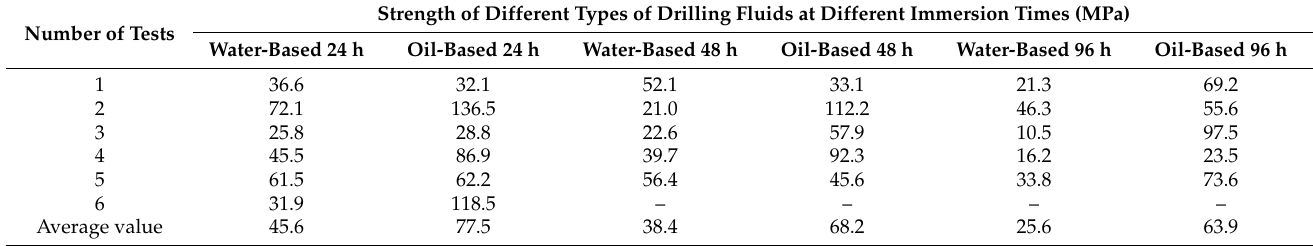
Table 1. Strength test results of mud shale in Well A after soaking in mud.